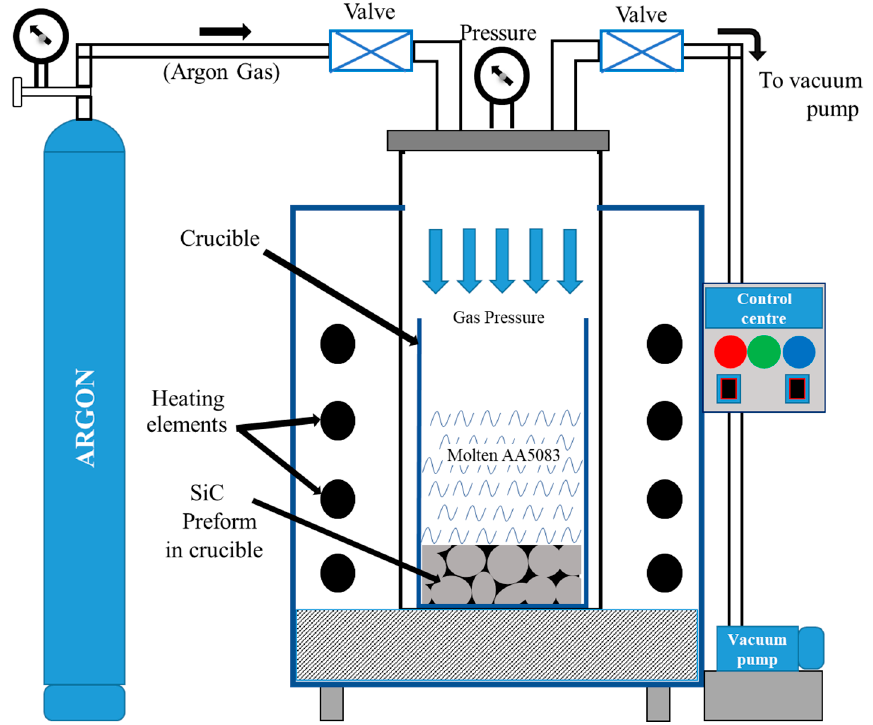
Figure 1. Gas pressure infiltration setup.